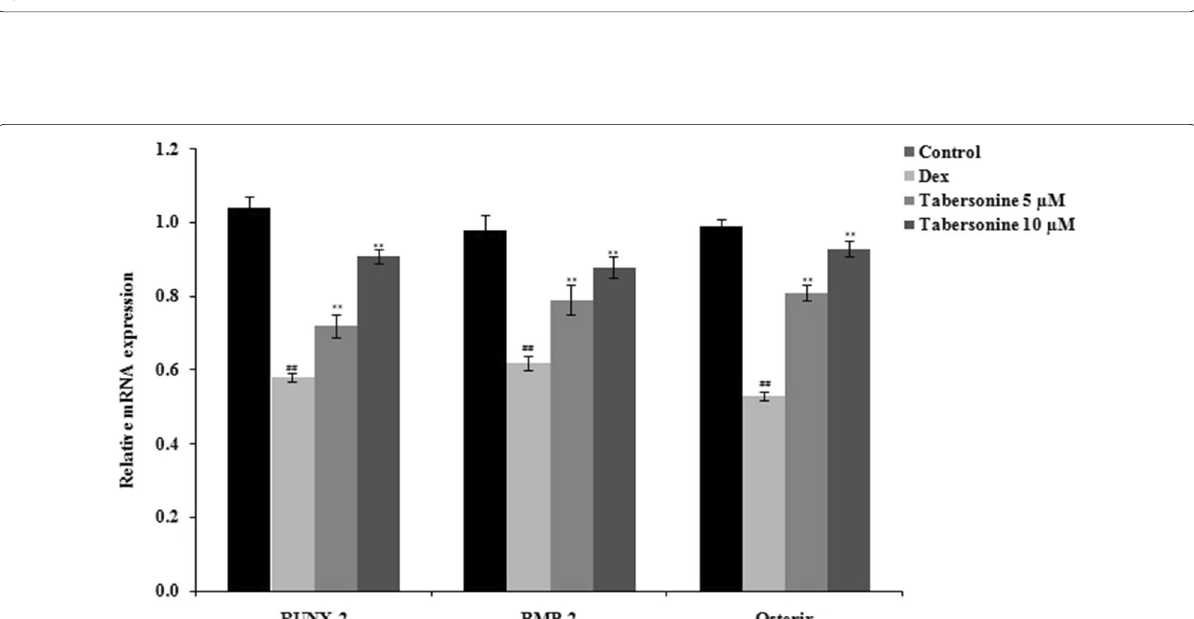
Fig. 5 Effect of tabersonine on apoptosis of dexamethasone-treated osteoblasts. Means group